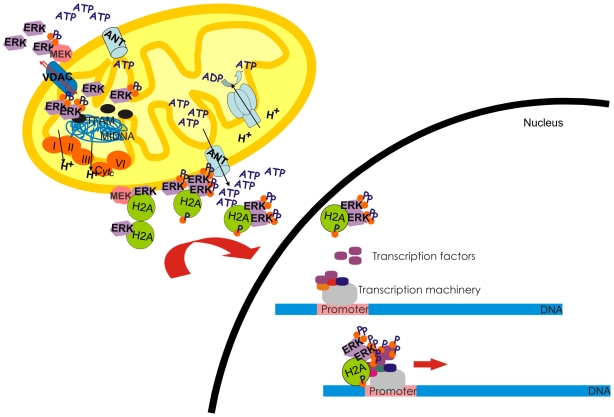
Postulated structural interactions of hERK1 with mitochondria.Scheme showing a new perspective for the physiological role of hERK1 in relation to the regulation of cellular signalling and trafficking in HeLa cells. ERK1 may be a carriage protein that would facilitate histone traffic to the ATP source in the surroundings of the OMM, and afterwards to the nuclei. Altogether this complex may interact with ERK transcription factors and the transcription machinery to enhance RNA synthesis. ERK translocation into and out the mitochondria may occur via VDAC protein. Once inside, the kinase may regulate mtDNA transcription by regulation of TFAM. I, II, III and IV: mitochondrial electron transport chain complexes, Cyt: cytochrome c, ANT: ATP carrier. The model is simplified for H2A, but the same is proposed for H4.